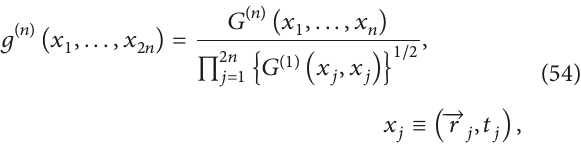
different to (3.C) and implies the squeezing of the distribution (𝑛, 𝑚, |𝑧|) along the line 𝑛 = 𝑚 P 퐸